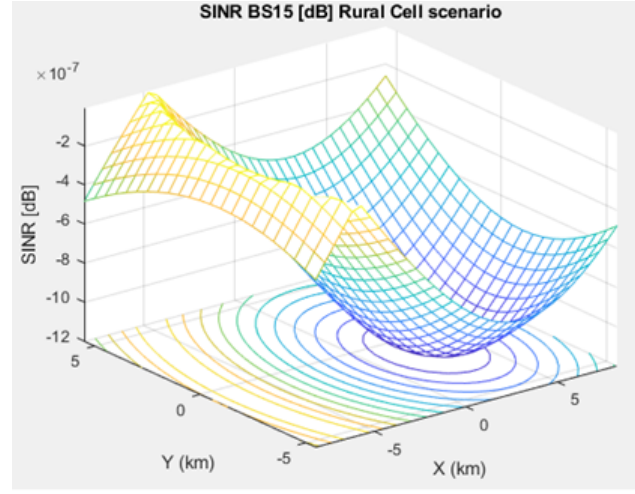
Figure 13. Signal Interference to Noise Ratio for BS No. 15 in a rural macrocell scenario.